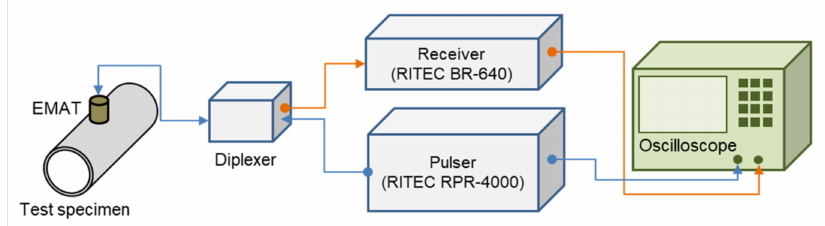
Figure 8. Schematic of the experimental